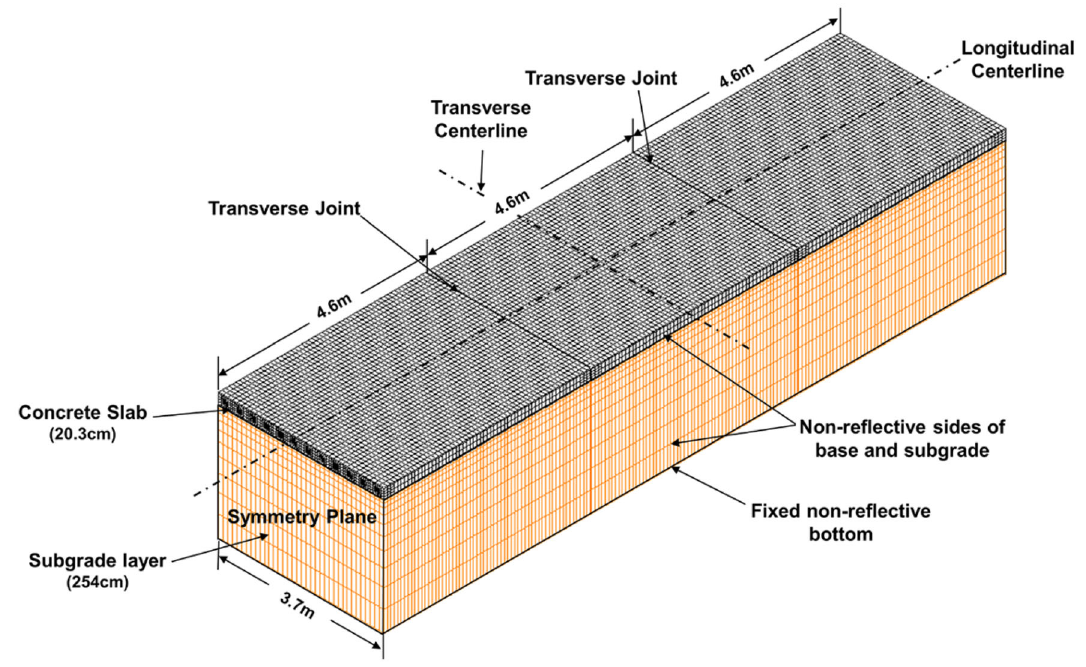
Fig. 8 Finite element modeling of JPCP with actual dowel bar dimension.